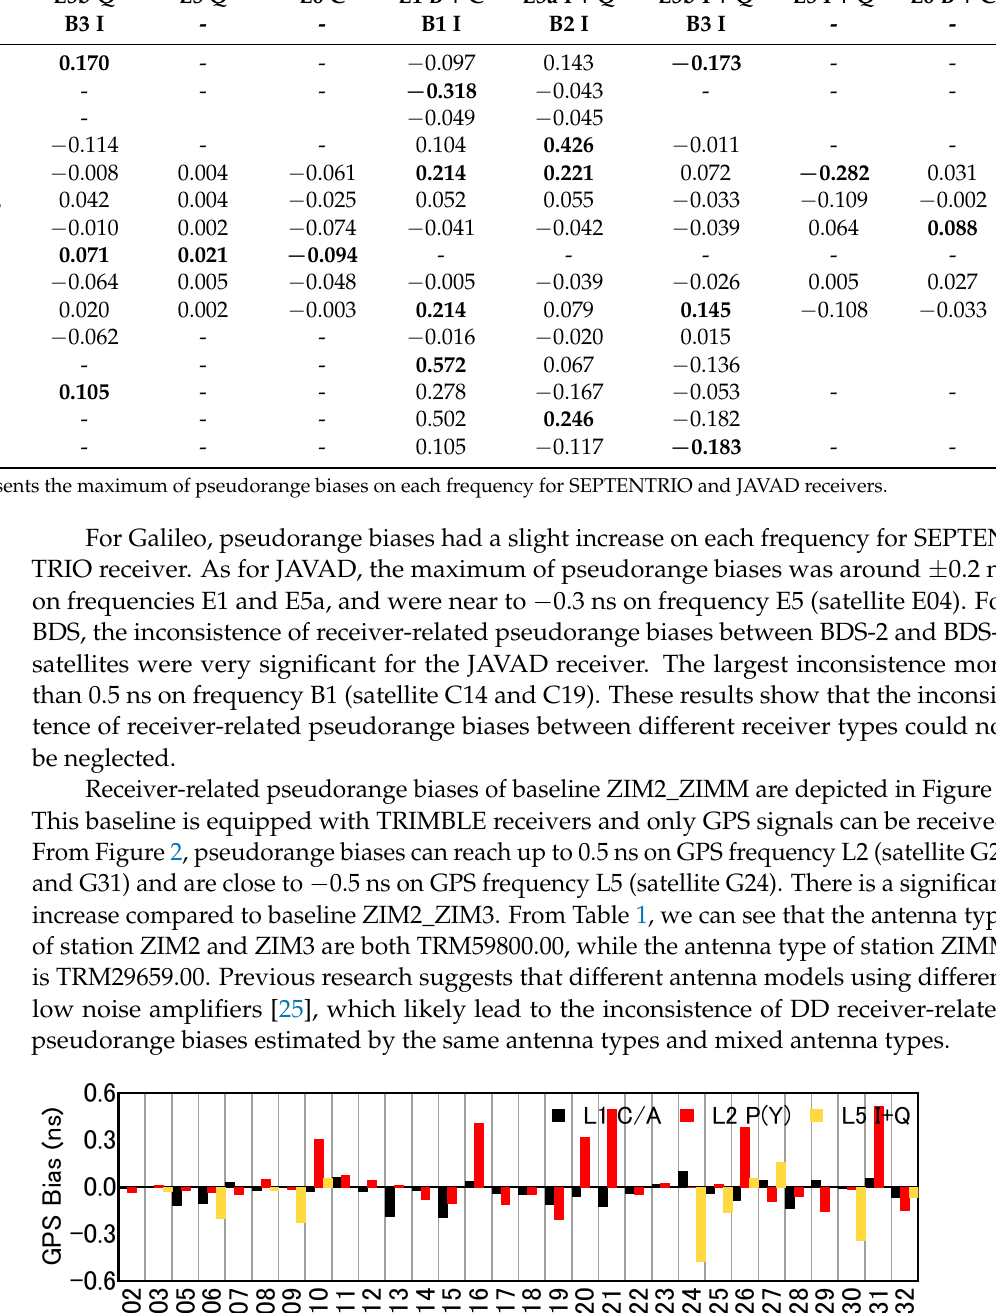
increase appeared on frequency L5 (satellite G06). Table 2. Receiver-related pseudorange biases of baselines USN7_USN8 and GODS_GODN for GPS, Galileo and BDS (unit: ns).